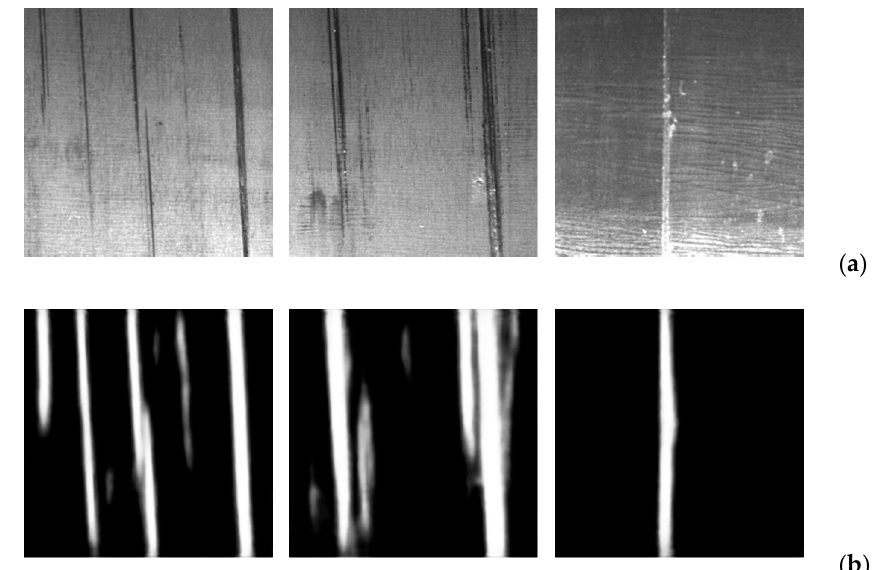
Figure 4. Test images ( a ) and damage recognition results ( b ).